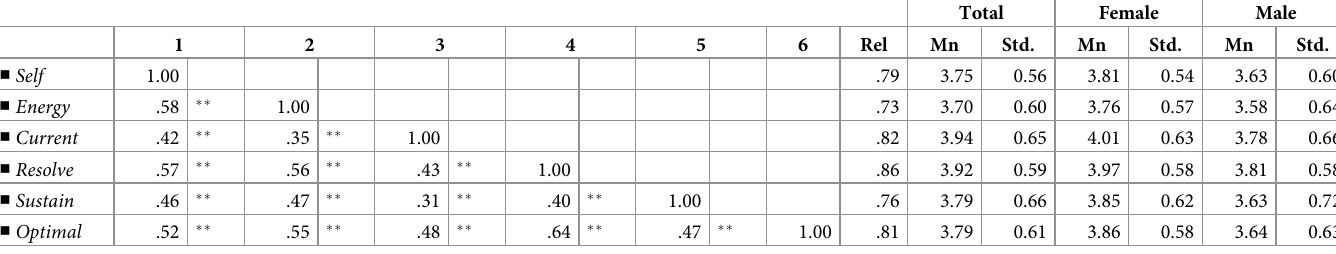
Table 1. Correlations between mean scale